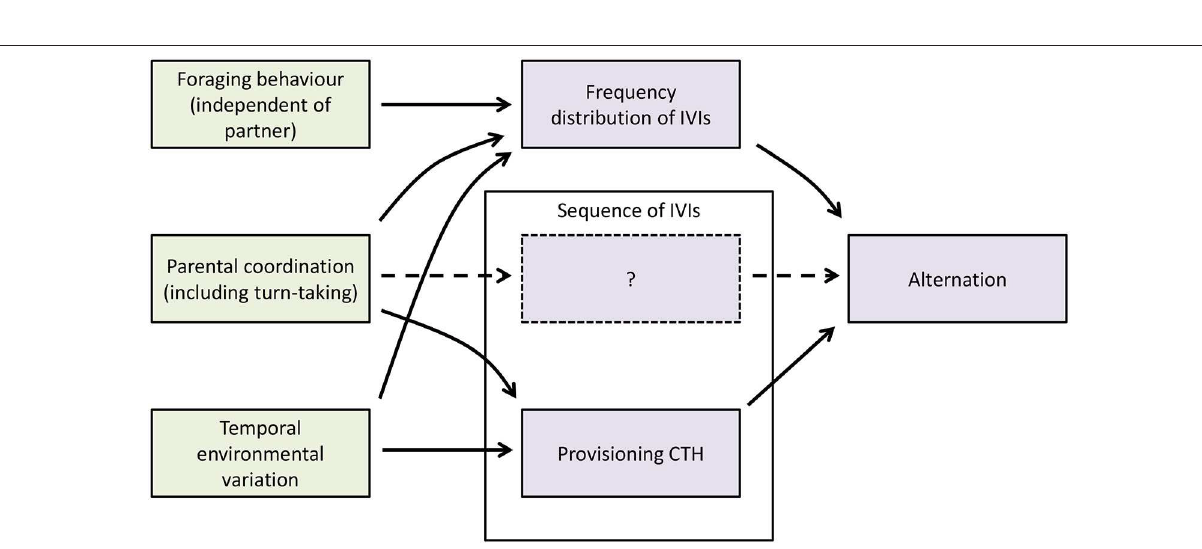
FIGURE 4 | A conceptual framework for understanding the behavioral and ecological processes and factors affecting alternation. Green boxes are behavioral or ecological processes or factors; mauve boxes are statistical properties of the sequences of provisioning visits by individual parents or pairs. IVIs are inter-visit intervals, the intervals between successive provisioning visits to the nest by a given parent. The sequence of IVIs box contains a dashed box containing a question mark, because it is not clear whether turn-taking produces statistical properties in addition to provisioning CTH that depend on the sequence of IVIs and affect the level of